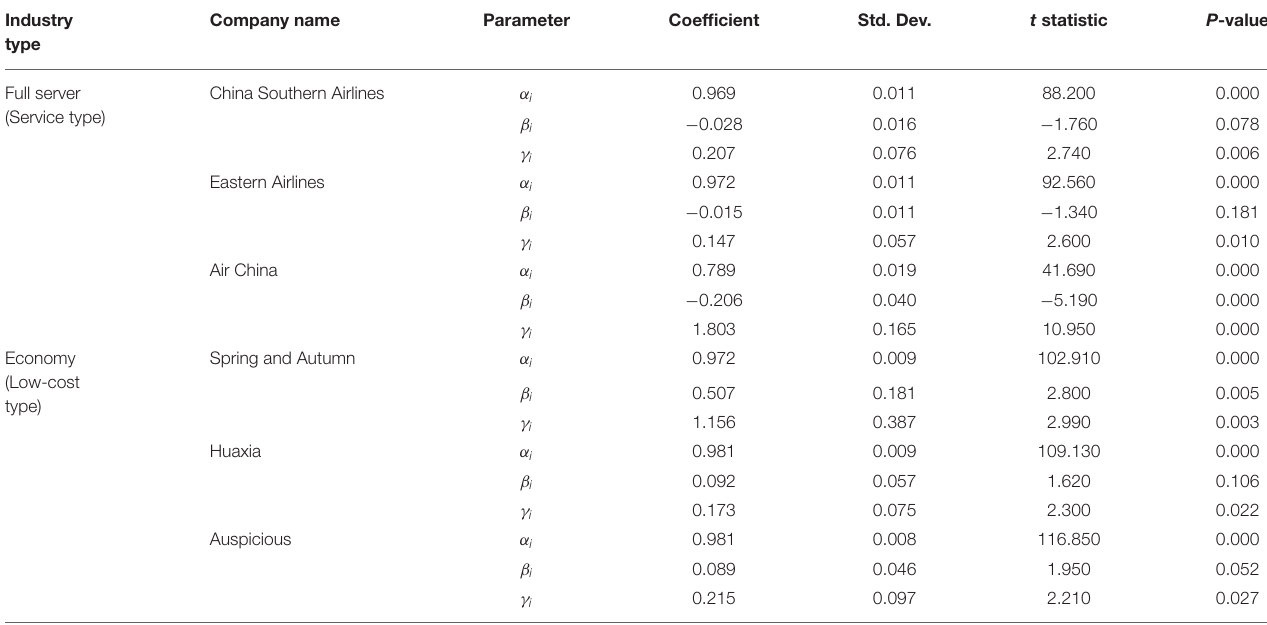
TABLE 5 | Robustness test